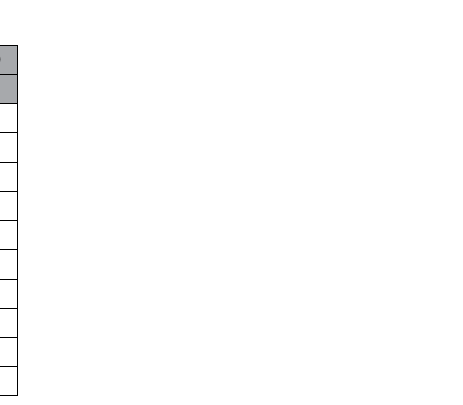
Figure 2. Flow diagram illustrating the phases of this randomized, double-blind, placebo-controlled, parallel- group study.